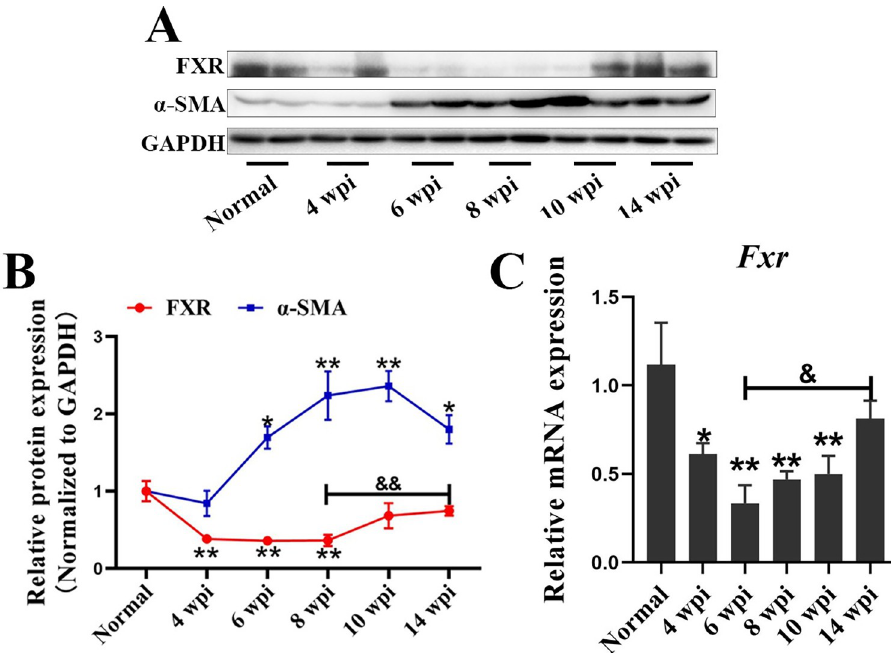
Fig 1. FXR decreases in mice livers with pathological injuries induced by S . japonicum infection. (A) Expression levels of hepatic FXR and α -SMA in mice infected with S . japonicum at different time-points were measured by western blot. (B) The relative expression levels of FXR and α -SMA were normalized to GAPDH, and the fold changes were calculated by comparing with the normal group. (C) The hepatic mRNA level of Fxr in mice infected with S . japonicum was detected by RT-qPCR. Data are presented as mean ± SEM. � P < 0.05, infected groups vs normal group; �� P < 0.01, infected groups vs normal group; & P < 0.05, && P <